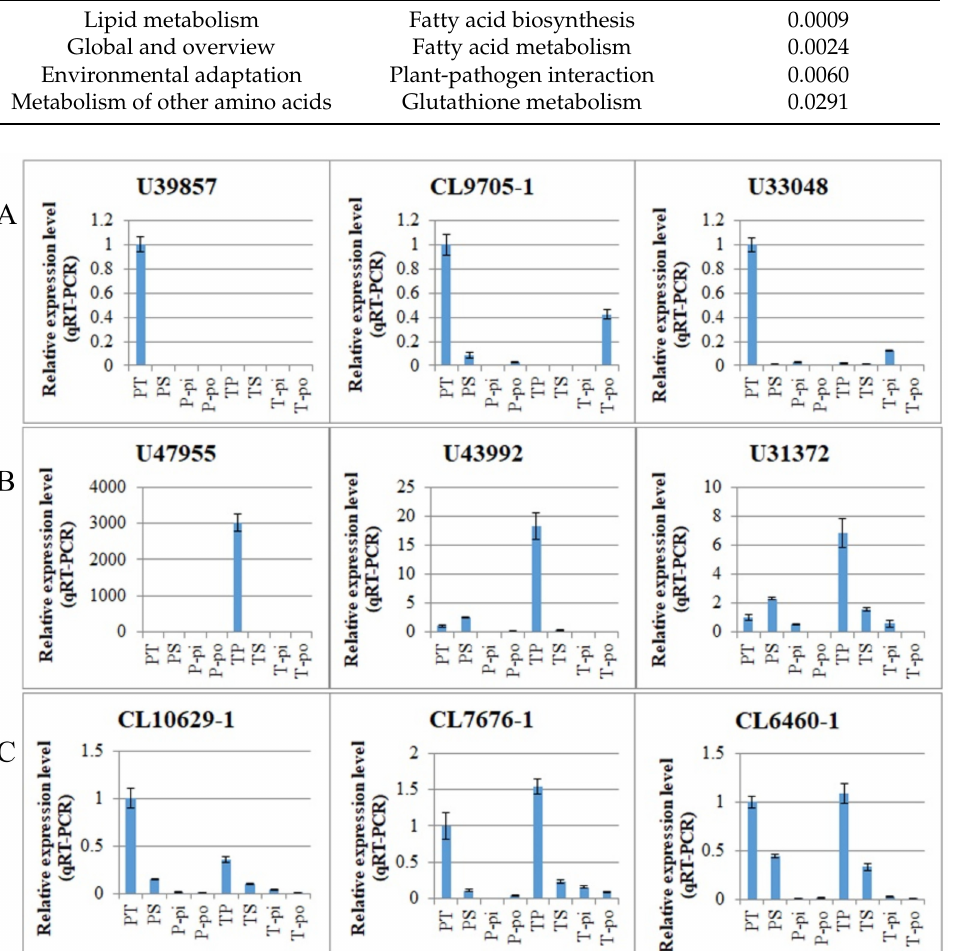
Figure 5. Expression patterns of DEGs downregulated in the PS vs. PT and/or TS vs. TP comparisons detected by qRT-PCR. ( A ) Expression patterns of DEGs downregulated specifically in the PS vs. PT comparison; they were expressed highly in the PT pollination; ( B ) Expression patterns of DEGs downregulated specifically in the TS vs. TP comparison; were expressed highly in the TP pollination; ( C ) Expression patterns of DEGs downregulated in the PS vs. PT and TS vs. TP comparisons; they were expressed highly in the PT and TP pollination. PT, pistils of pin after cross-pollination. PS, pistils of pin after self-pollination. P-pi, pin pistils without pollination. P-po, pin pollen. TP, pistils of thrum after cross-pollination. TS, pistils of thrum after self-pollination. T-pi, thrum pistils without pollination. T-po, thrum